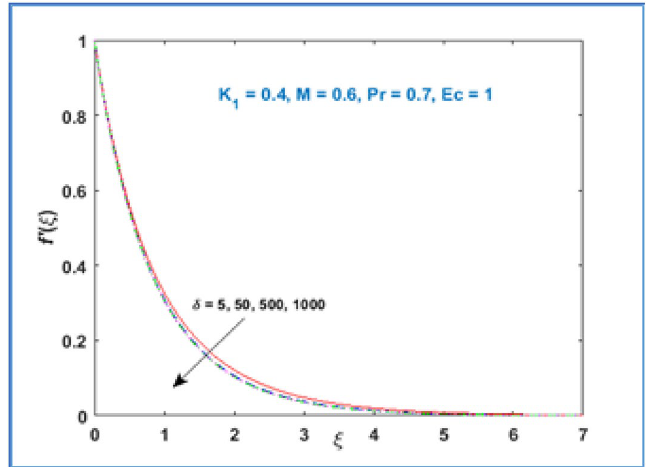
Figure 4. f ′ (ξ) versus δ .